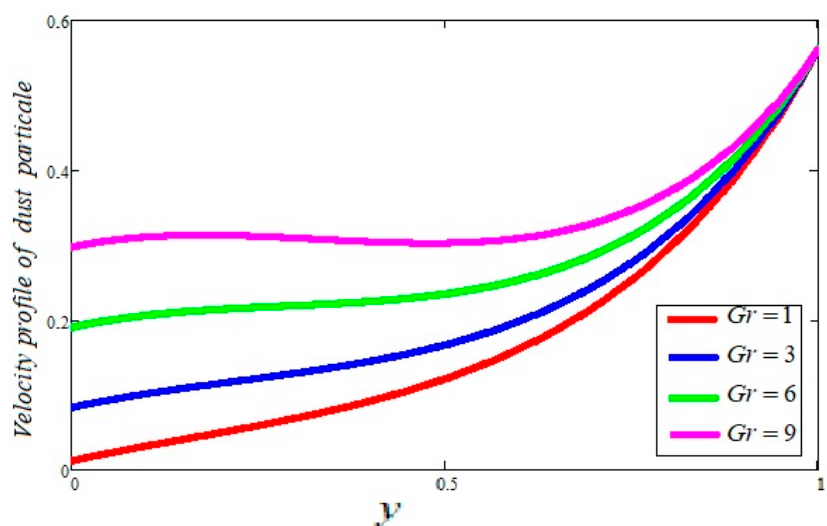
Figure 3. Impact of Gr on the profile of dust particles